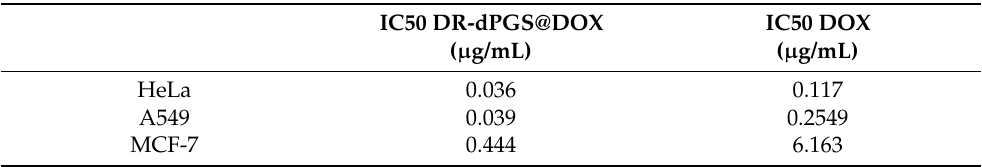
Table 2. Calculated IC50 values for DR-dPGS@DOX and free DOX.